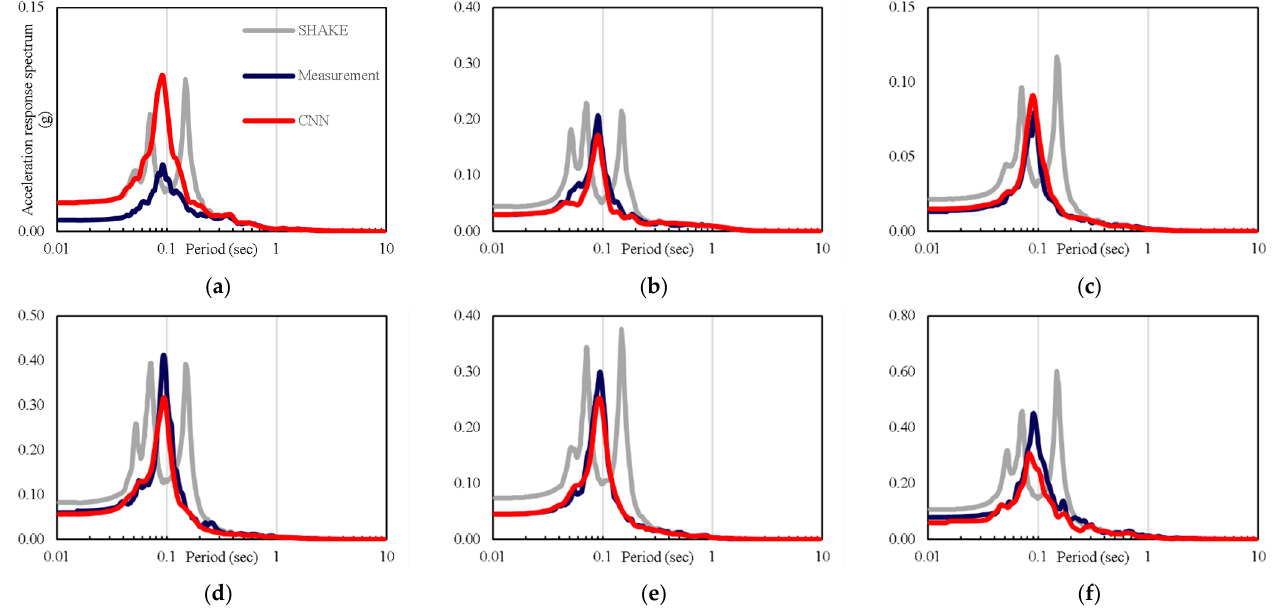
Figure 17. The six samples of acceleration response spectra measurements and predictions at site IWTH14. ( a )